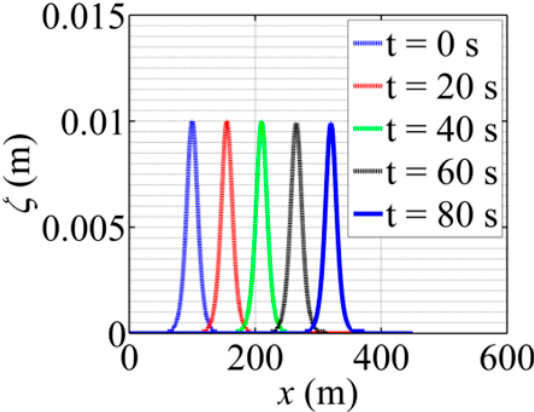
Figure 3. Simulated solitary wave in a frictionless channel .